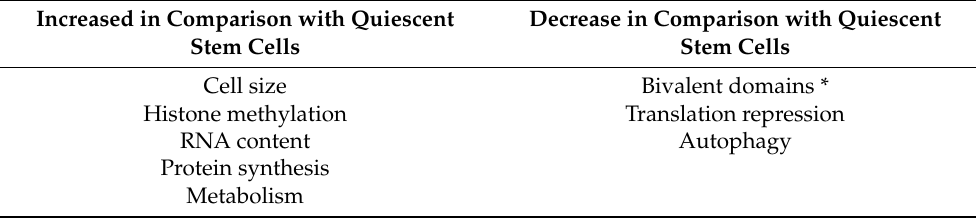
Table 1. Changes in activated HSCs in comparison with quiescent ones, adapted from